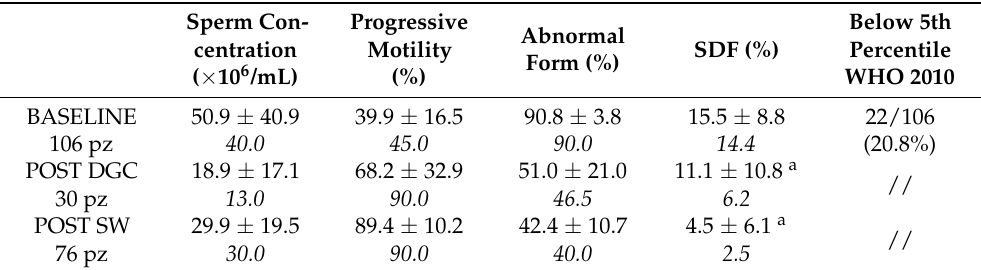
Table 2. Comparison of semen parameters before and after sperm selection procedures. Continuous variables are presented as mean ± SD and median (in italics); categorical variables are presented as counts and